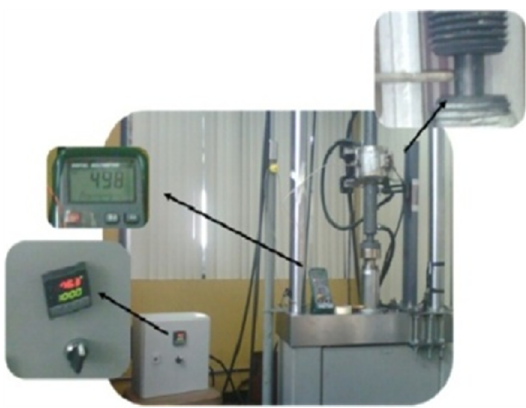
Figure 4. Experimental setup 1